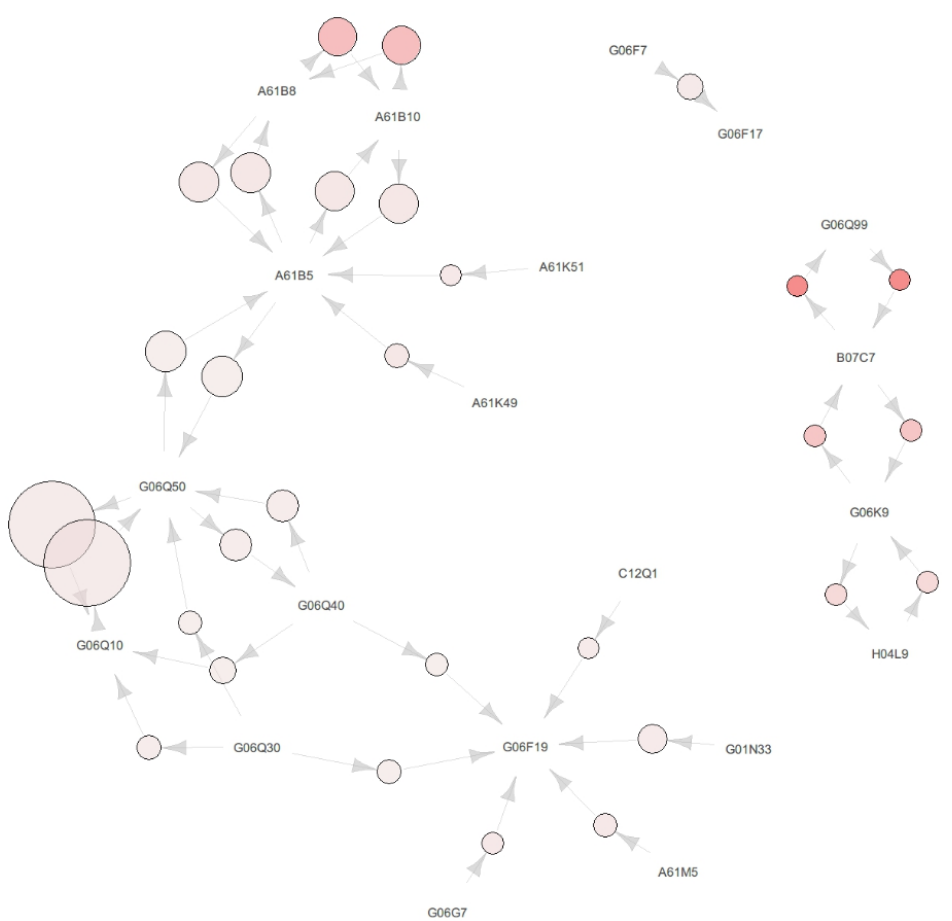
Figure 3. Association map of pharmaceutical technology between 2000 and 2007.